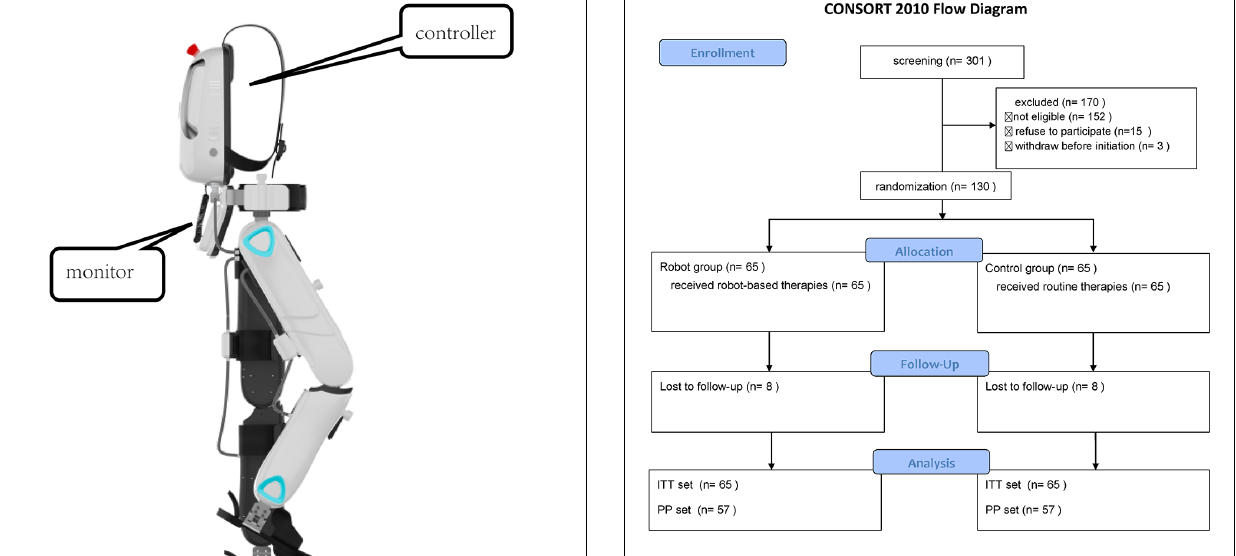
FIGURE 2 | Consort flow diagram of the